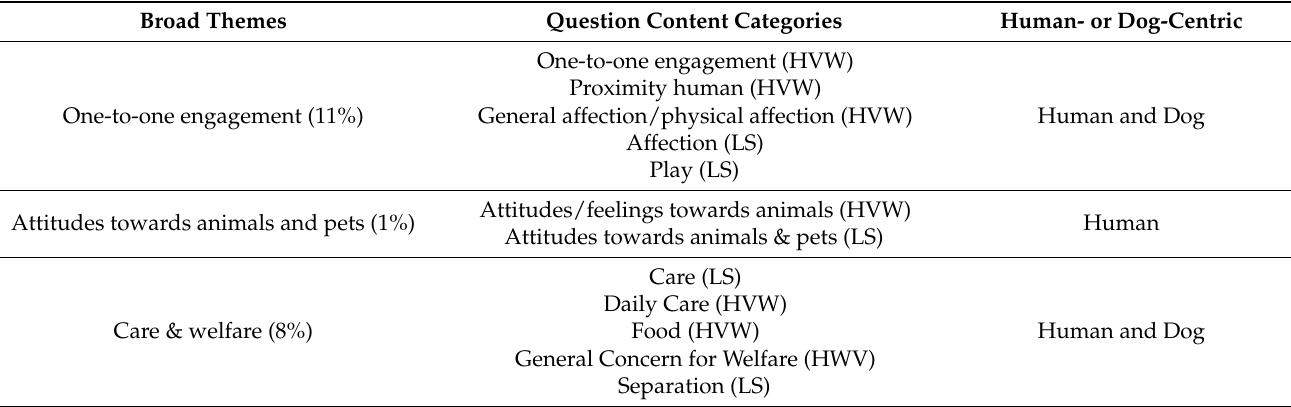
Table 5. Question content categories for the 228 HDB questions were labelled independently by two researchers then grouped into ten broad themes (the percentage of questions in each broad theme in shown). Each theme was then classified as either human- and/or dog-centric (the original 228 questions can be seen in Supplementary Materials, Table